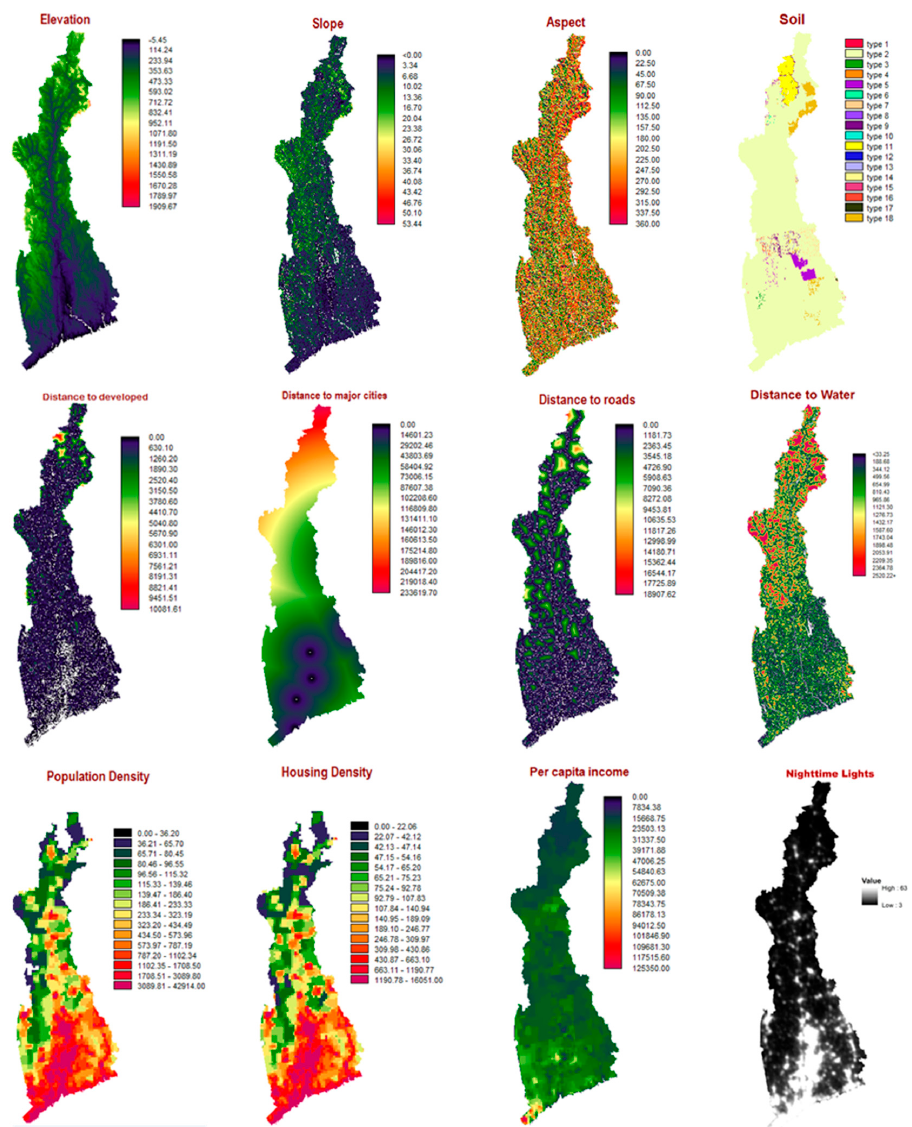
Figure 2. Maps of the input explanatory drivers.